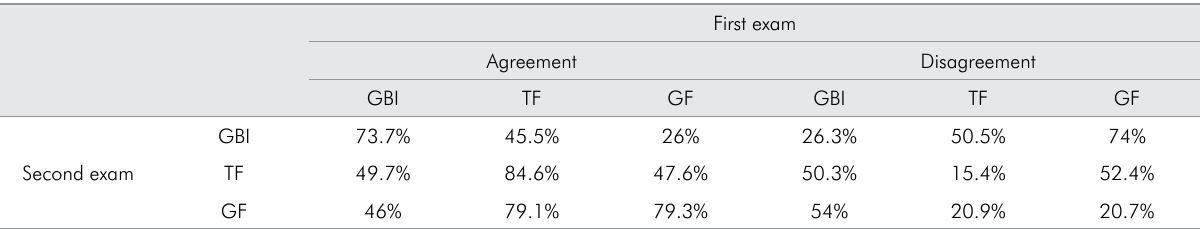
Table 3. Percentage of sites with agreement and disagreement for each one of the nine protocols.